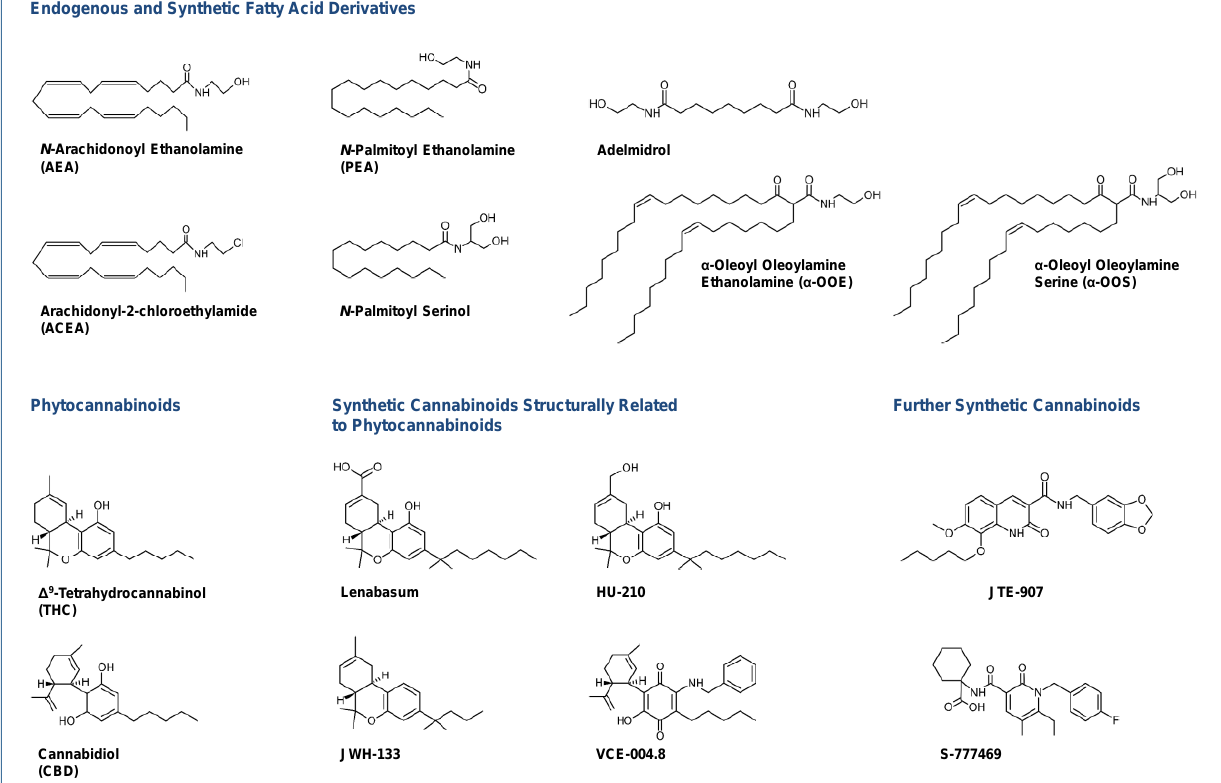
Figure 1. Selected endocannabinoids and phytocannabinoids and their derivatives currently under investigation or in use for the treatment of skin diseases. Most clinical studies have focused on the effects of CBD in various dosage forms and N -palmitoyl ethanolamine (PEA; Figure 1) for symptom relief in atopic dermatitis [16–18] and other diseases. For some diseases, there are only case reports on the potential efficacy of cannabinoids, such as in epidermolysis bullosa [19,20], pyoderma gangrenosum [21,22], pruritus due to cholestatic liver disease [23] and lichen simplex chronicus [24]. Figure 1 shows a collection of chemical formulae of the endocannabinoids, endocannabinoid-like substances and phytocannabinoids and their derivatives that are currently being studied or used for the treatment of skin